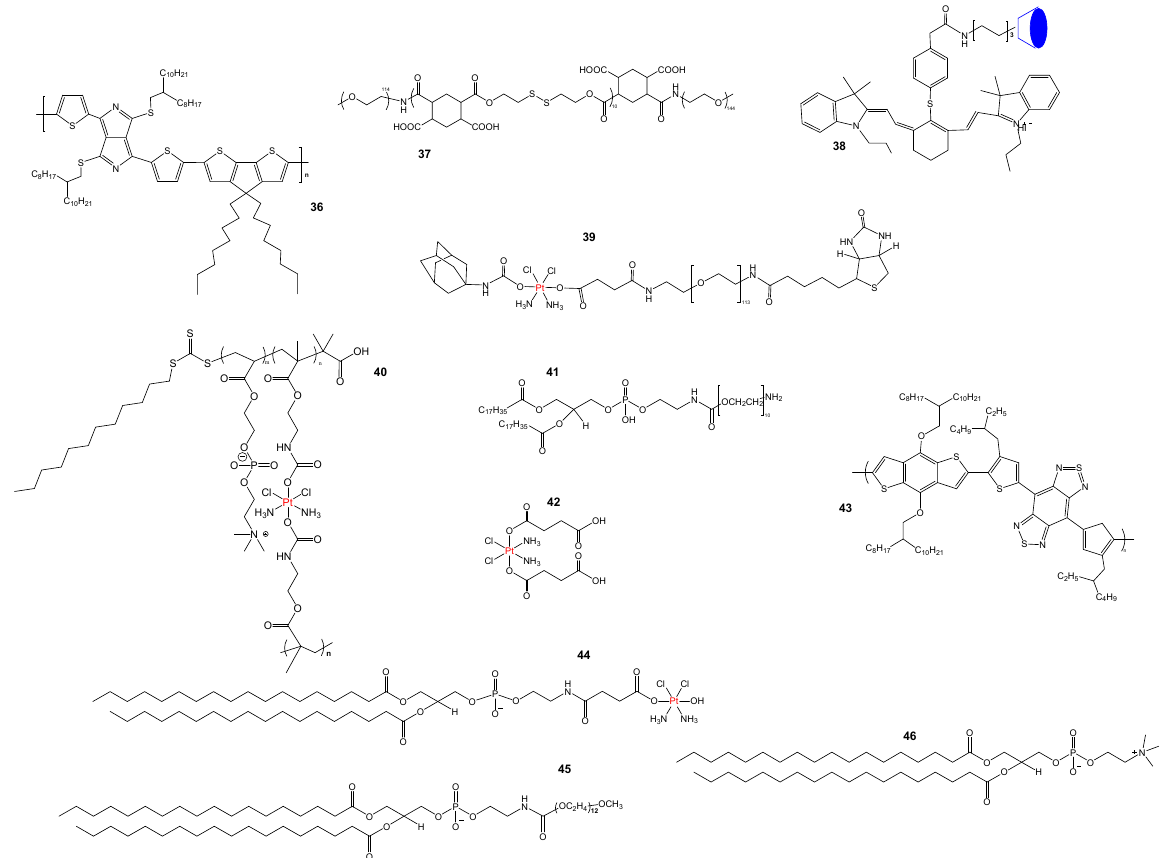
Figure 8. Structures of Pt-based prodrugs activated via thermal/invisible light stimuli. ( 36, 37 ) The Zhang group obtained the prepared nanocomplexes by systematically combining P1 ( 36 ) with DAP-F ( 37 ) and Pt. ( 38 , 39 ) Pt(IV)-NPs are mainly composed of IR1780 ( 38 ) and Ad-Pt(IV)-PEG-biotin ( 39 ). ( 40 ) The structure of prodrug. ( 41 , 42 , 43 ) CPNP-Fc/Pt consists mainly of DSPE-PEG500-NH 2 ( 41 ), Pt(IV) prodrug ( 42 ) and CP ( 43 ). ( 44 , 45 , 46 ) (CAT)@Pt(IV)-liposome consisting of DSPE-Pt(IV) ( 44 ), DSPE-PEG5K ( 45 ) and DPPC ( 46 ).